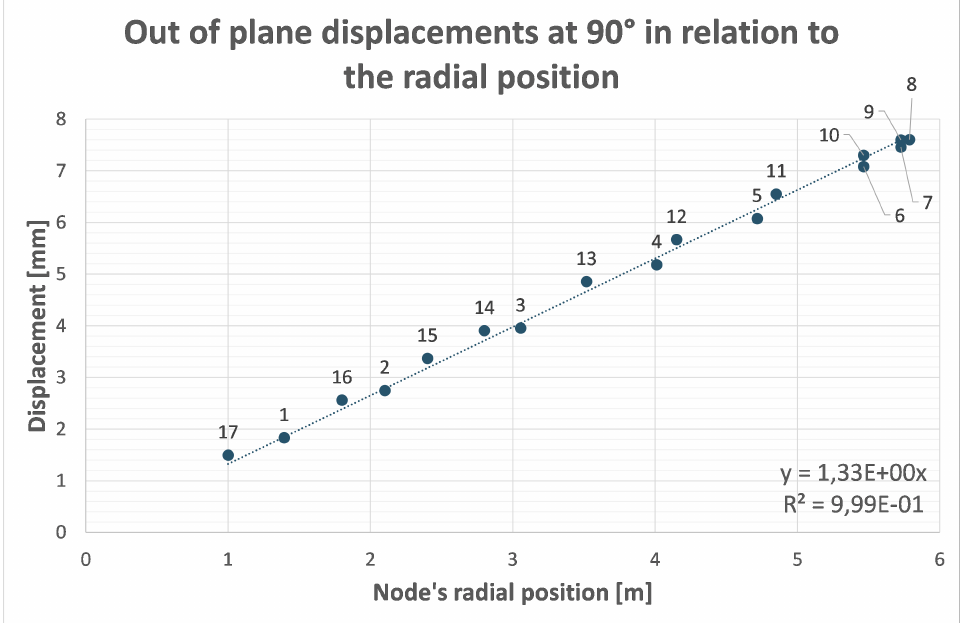
Figure 4. Out-of-plane displacements of some selected nodes along the magnet line when the structure is in a horizontal position